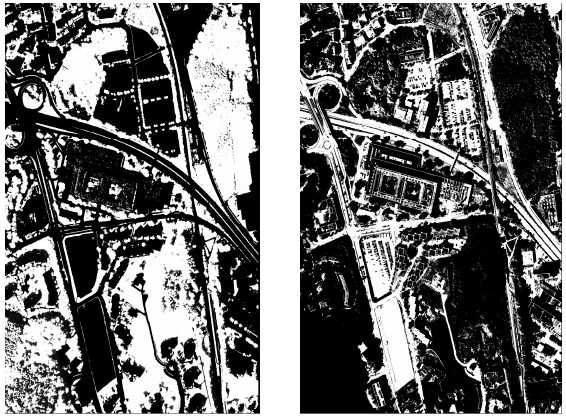
Figure 2. Examples of the L1 filter